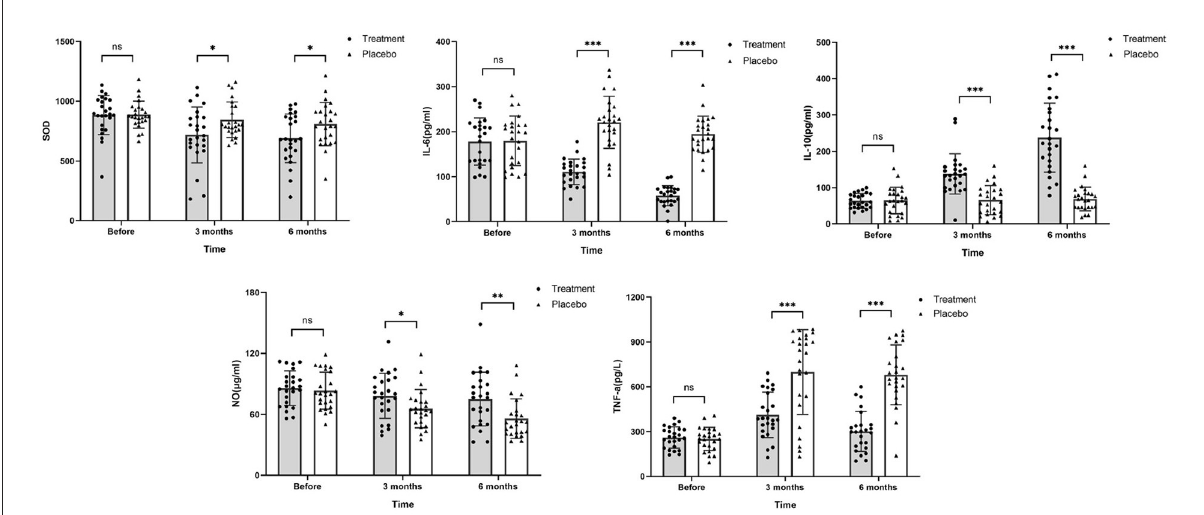
FIGURE6 Changes in SOD, IL-6, IL-10, NO, and TNF- α levels after chemotherapy. The values of SOD, IL-6, and TNF- α in the treatment group were higher than those in the placebo group, while levels of IL-10 and NO were noticeably lower than those in the placebo group after chemotherapy (ns, no significance difference; * P ≤ 0.05, ** P ≤ 0.01, and *** P ≤